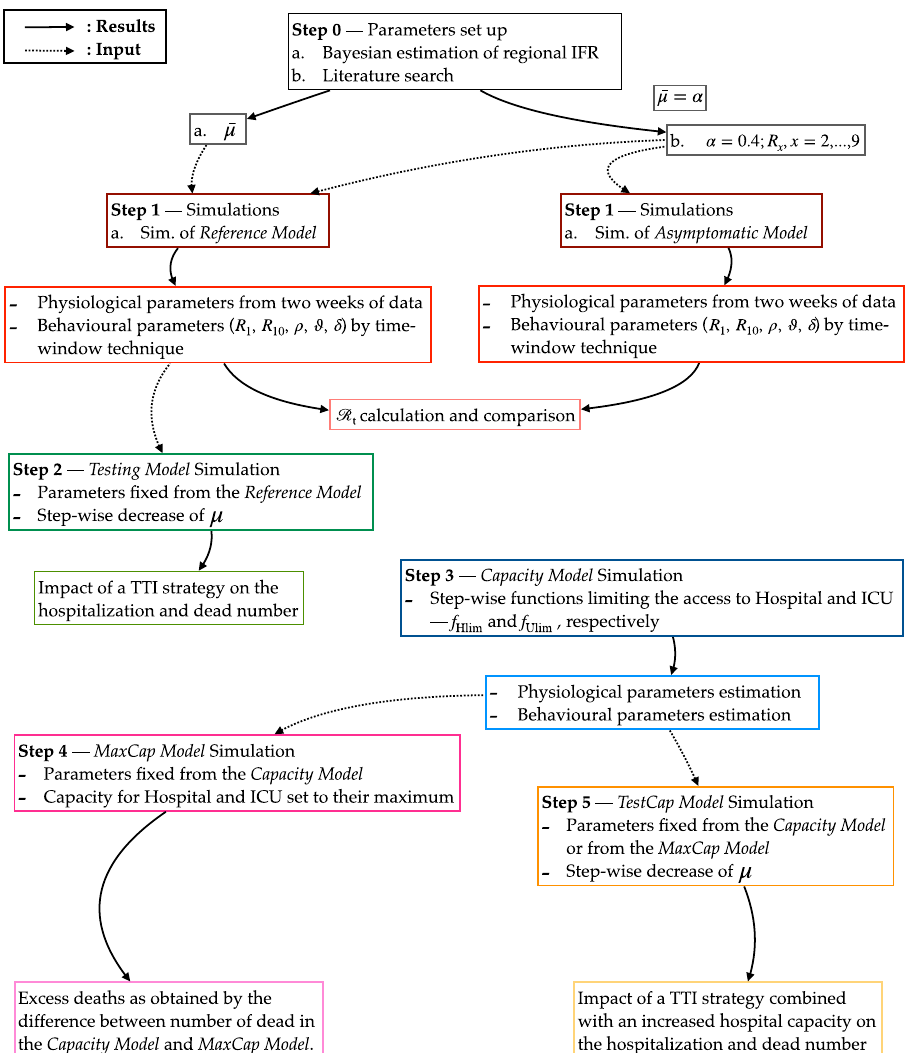
Fig. 2 Flowchart of the study design including features and purposes of the SECIRD models. The fl owchart illustrates the steps followed to obtain the results. Each solid arrow points to the result obtained through the step from which the arrow starts, while each dotted arrow links the input to the step where that input was